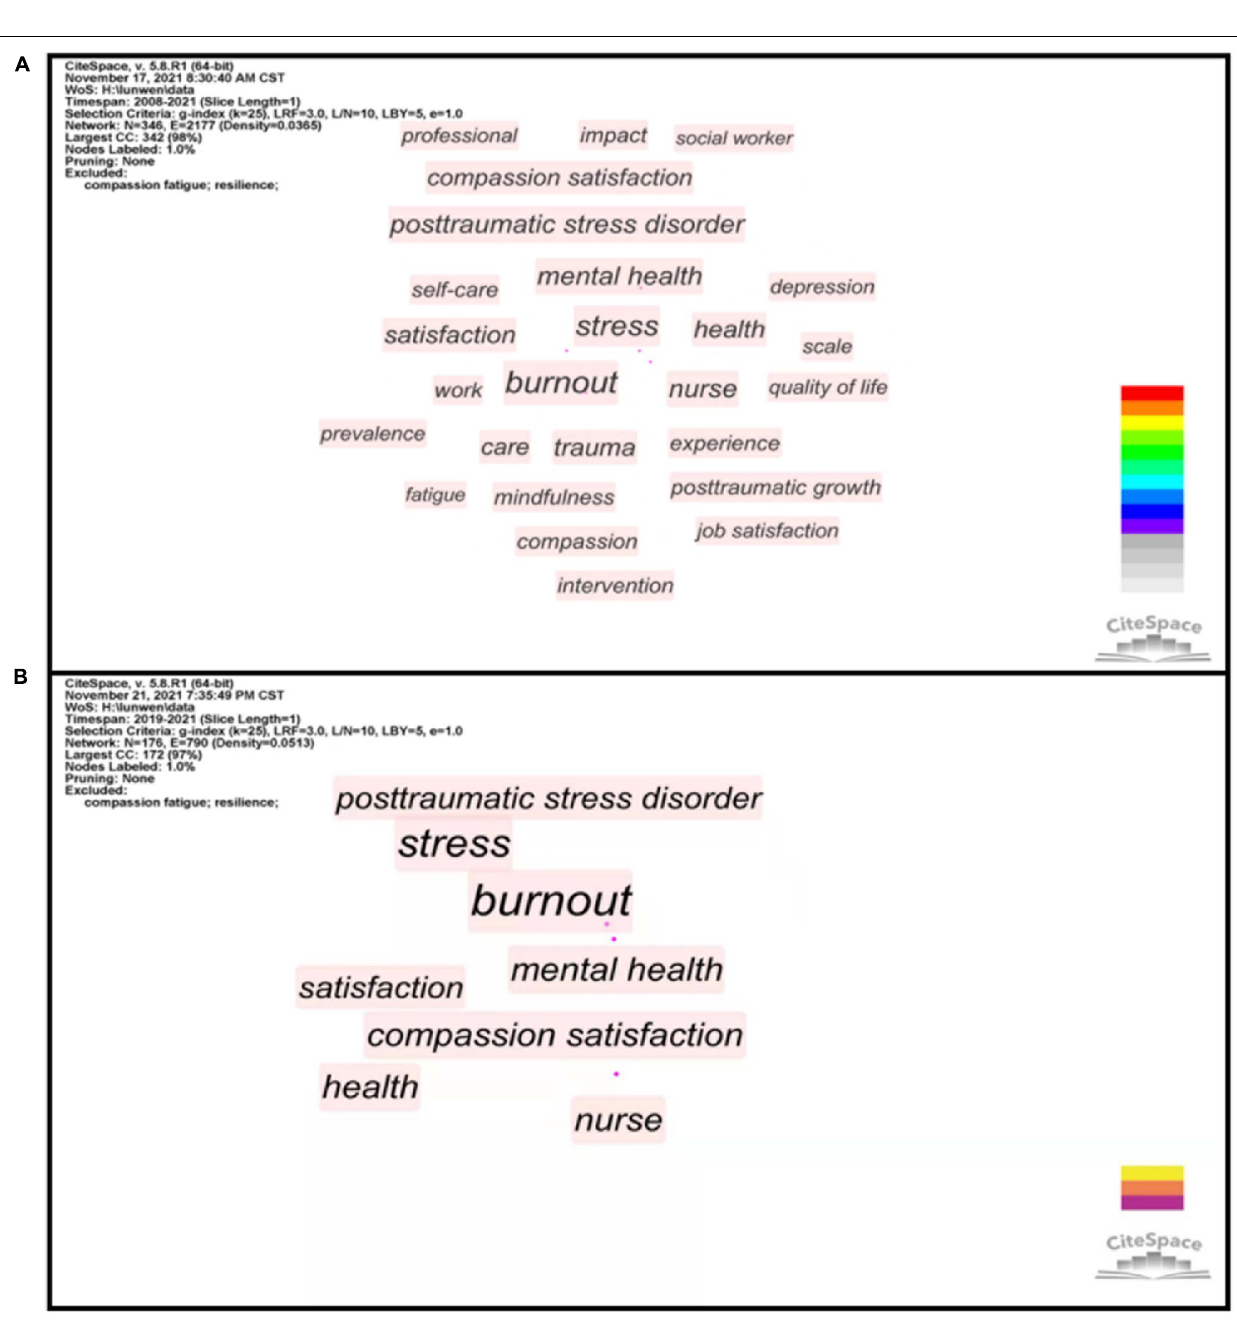
#10 is the smallest one (anxiety). For cited reference clusters, the map indicated that most clusters were concentrated from 2003 to 2020. The earlier research direction lay in clusters #7 (“child protection workers”) and #6 (“caregivers”), with most publications dated around 2006. This was followed by clusters #4 (“posttraumatic growth”), #1 (“anxiety”), and #9